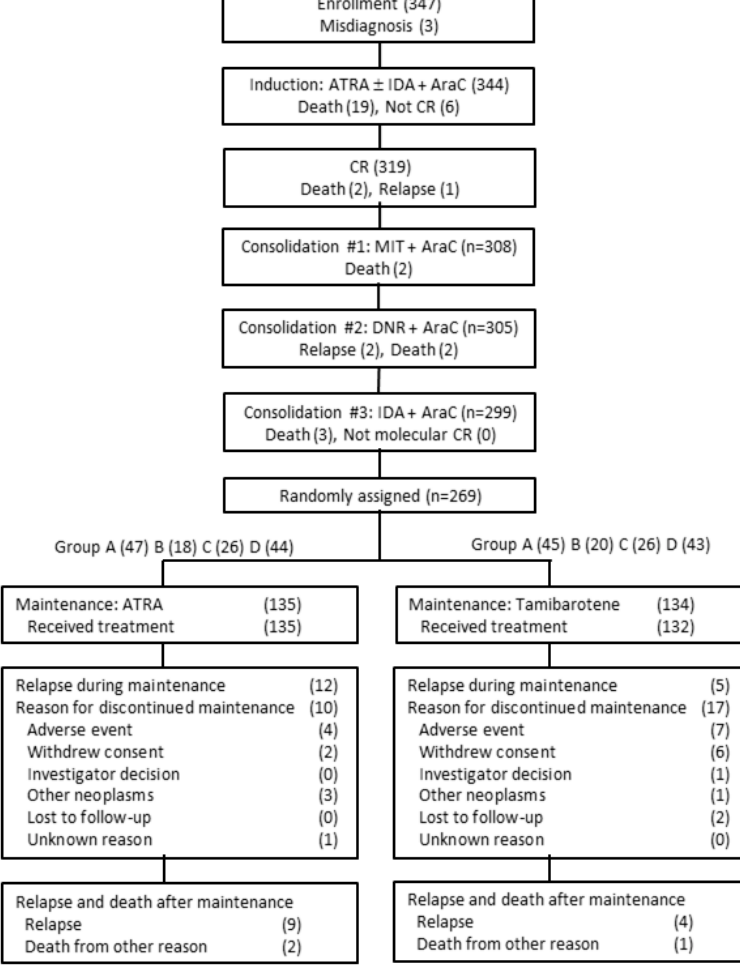
Figure 2. A CONSORT diagram before and after random assignment of the APL204 study. Numbers in parentheses refer to the numbers of patients. ATRA, all- trans retinoic acid; DNR, daunorubicin; IDA, idarubicin; MIT, mitoxantrone; AraC, cytarabine; CR, complete remission.